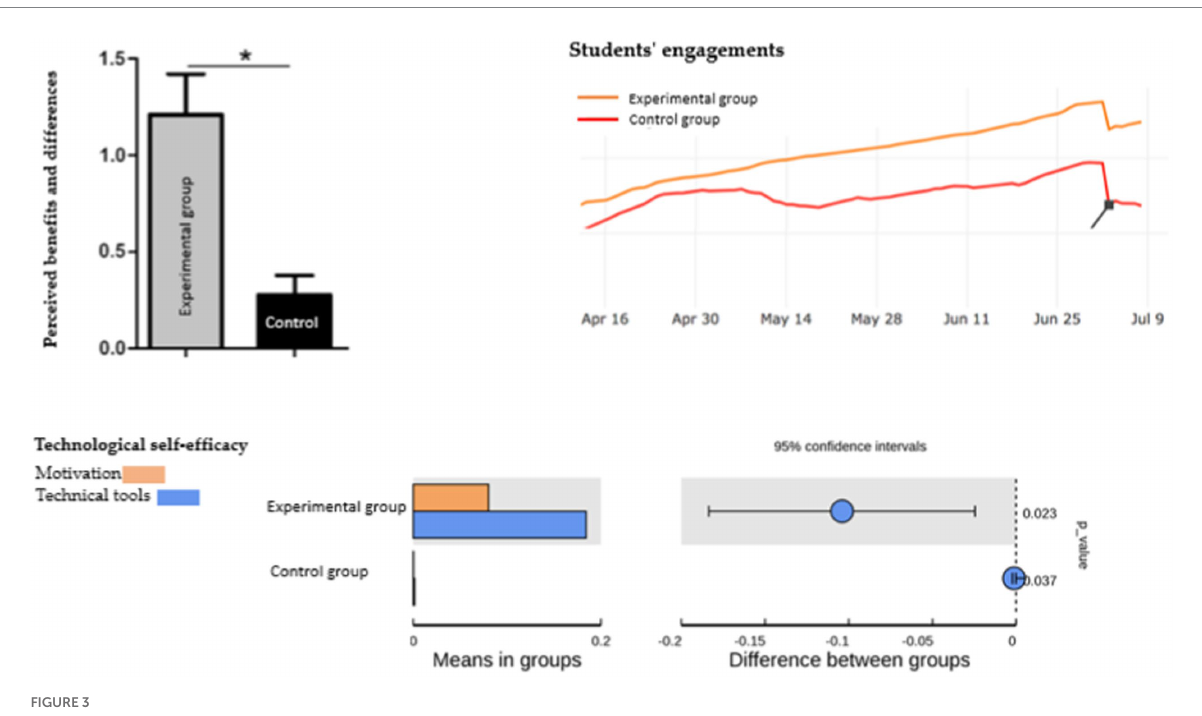
FIGURE 3 Statistical analysis among groups using learning